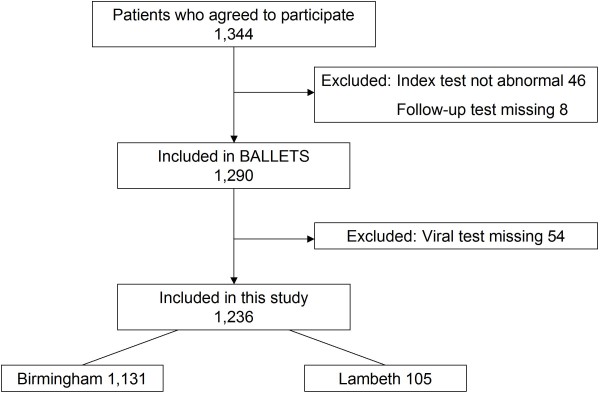
Flow diagram of exclusions and inclusions in the study.